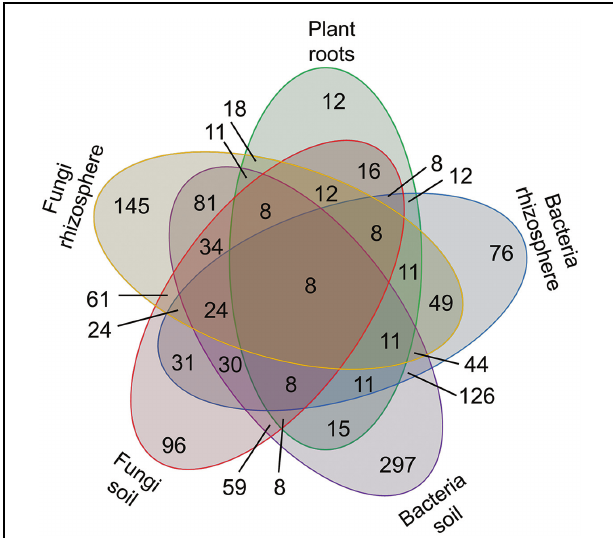
FIGURE 4 | Number of volatiles specific and common to plant roots, bacteria, and fungi. A total of 853 volatiles emitted by plant roots ( Figure 1 ) and belowground microbes were grouped based on their source/habitat in the five categories and are displayed in a Venn diagram. The numbers of volatiles specific or shared among categories are displayed